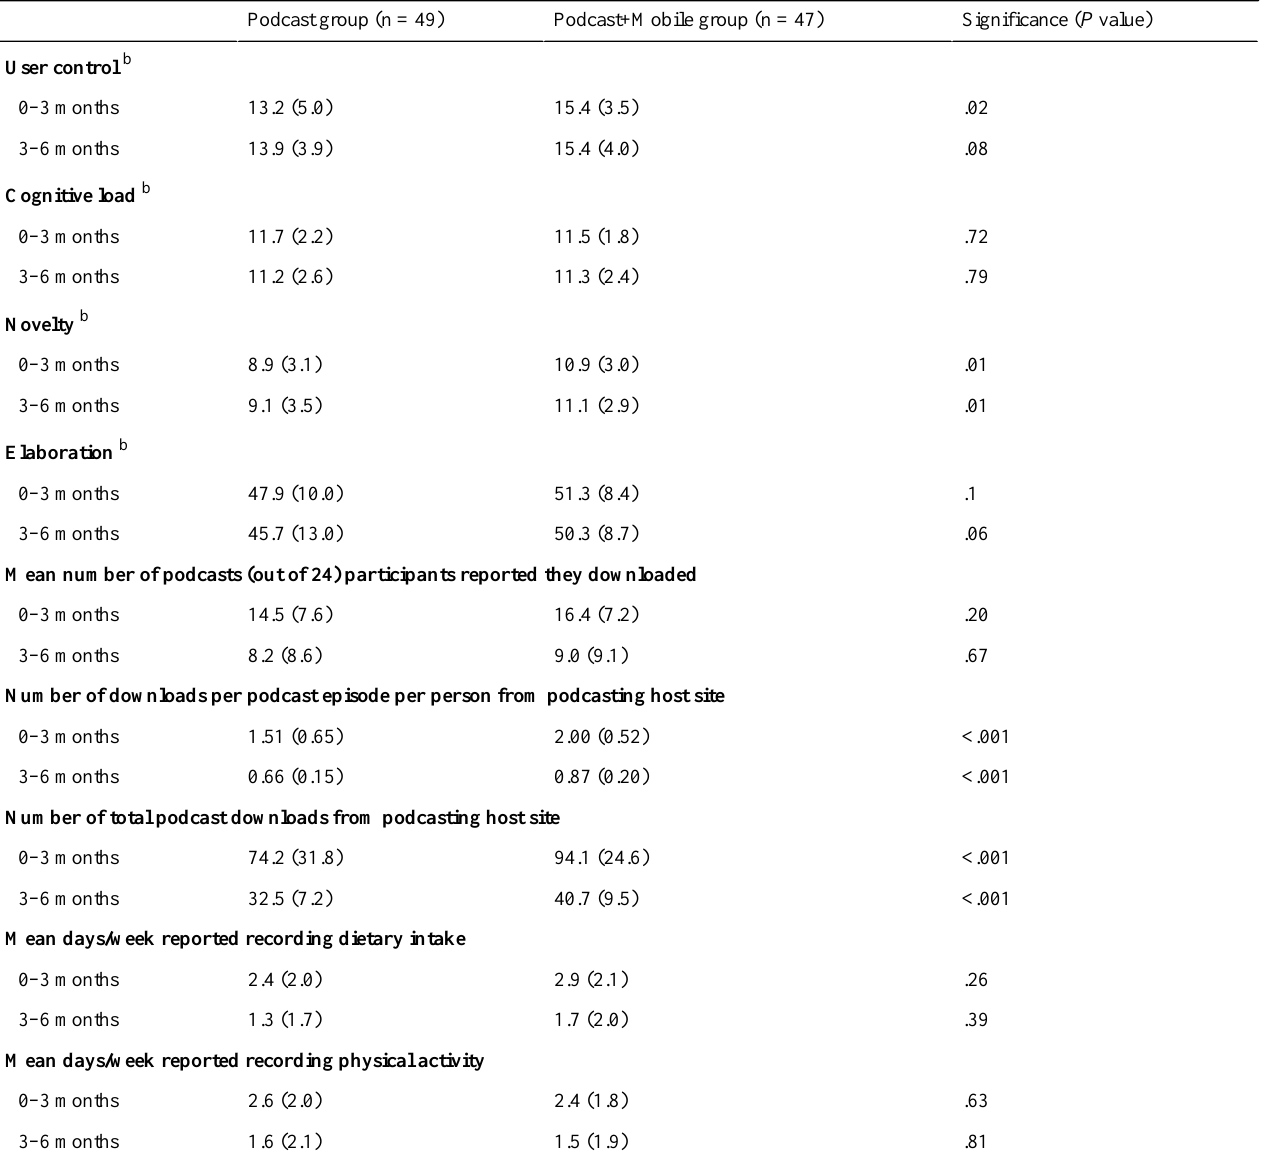
Table 3. Information processing variables at 3 and 6 months and podcast downloads and self-monitoring outcomes by group a